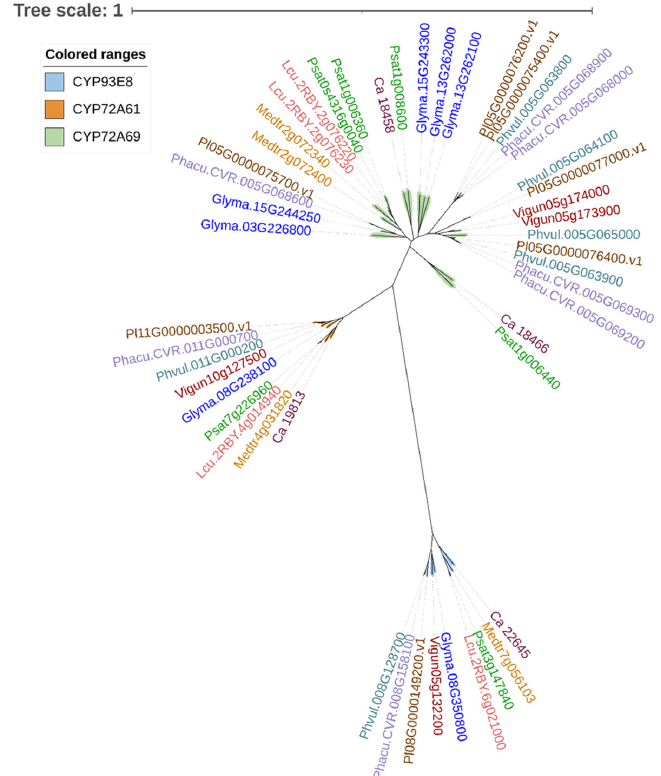
Figure 3. Neighbor-joining phylogenetic tree of cytochrome P450 monooxygenases (P450s) from pulse crop species. The amino acid sequences of pea CYP93E8, Medicago CYP72A61 and soybean CYP72A69 were retrieved from GenBank (accession AIN25420.1, ABC59088.1 and BAW35014.1, respectively) and were used for a blastp search against the proteomes of Medicago ( Medicago trun- catula , Mtruncatula_Mt4.0v1), common bean ( Phaseolus vulgaris L., Pvulgaris_v2.1), chickpea ( Cicer arietinum L., Carietinum_v1.0), soybean ( Glycine max , Gmax_Wm82.a4.v1), cowpea ( Vigna unguiculata L. Walp, Vunguiculata_v1.2), lima bean ( Phaseolus lunatus , Plunatus_V1), tepary bean (